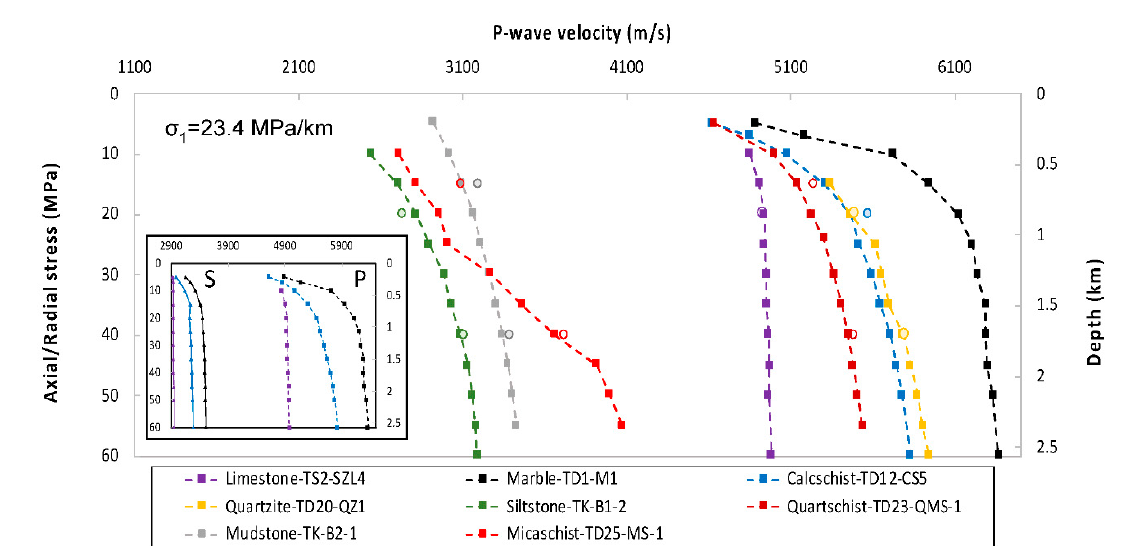
Figure 6. P-wave velocity as a function of axial stress, and thus depth below the surface, for all eight CCS tests conducted within experimental series B. After the samples were loaded until σ 1 = σ 2 = 55–60 MPa (dashed lines), unloading took place during which several acoustic measurements were taken to check for potential hysteresis effects (circular data points). Axial stress–depth relationship is taken from [35]. The graph in the inset presents the P- (dashed lines) and S-wave (continuous lines) velocities for the marble (black), limestone (purple), and calcschist (blue) samples used. Vp/Vs ratios at respectively 10 and 60 MPa of 1.65 and 1.69 (limestone), 1.72 and 1.82 (marble), and 1.62 and 1.77 (calcschist) were found.